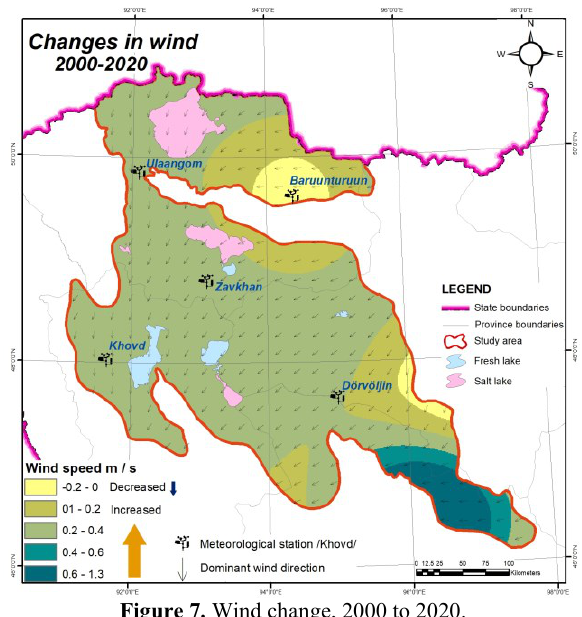
Figure 7. Wind change, 2000 to 2020.